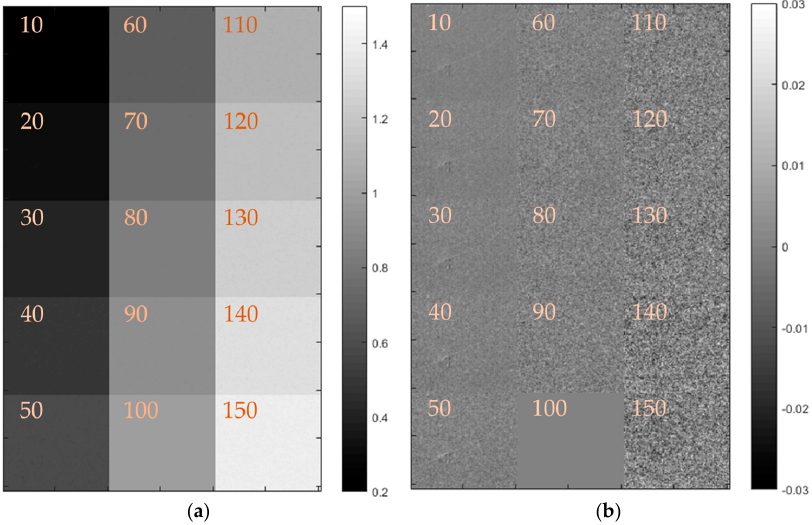
Figure 14 . Monochrome calibration montage from Ximea XiMU camera at 293 K. The values marked in the figures relate to the pressure in kPa ( a ) Intensity ratio with increasing pressure and ( b ) deviation from mean. Each square is approximately 25 mm × 25 mm.